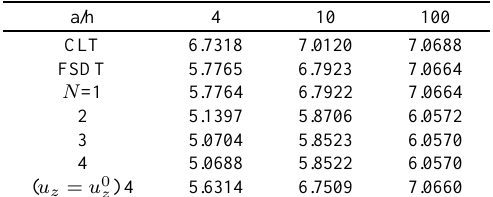
Table 2 One Layered orthotropic plate made of unidirectional lamina. Circular